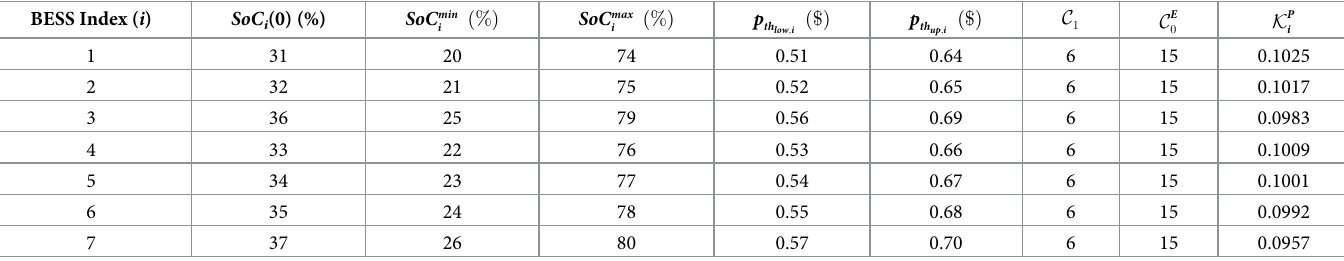
Table 1. Different parameters of the BESSs for SoC trajectory tracking control. BESS Index ( i